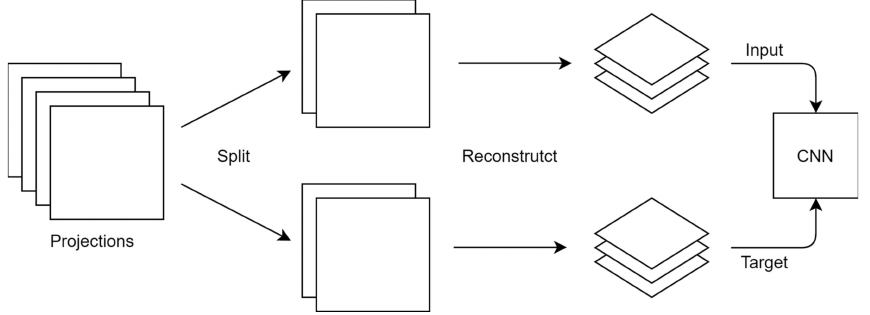
Figure 2 Workflow of the ML denoising approach. The acquired projections are divided into two stacks and reconstructed separately. While one reconstruction is used as an input, the other reconstruction is used as a target. The resulting model can be applied to each of the two reconstructions.